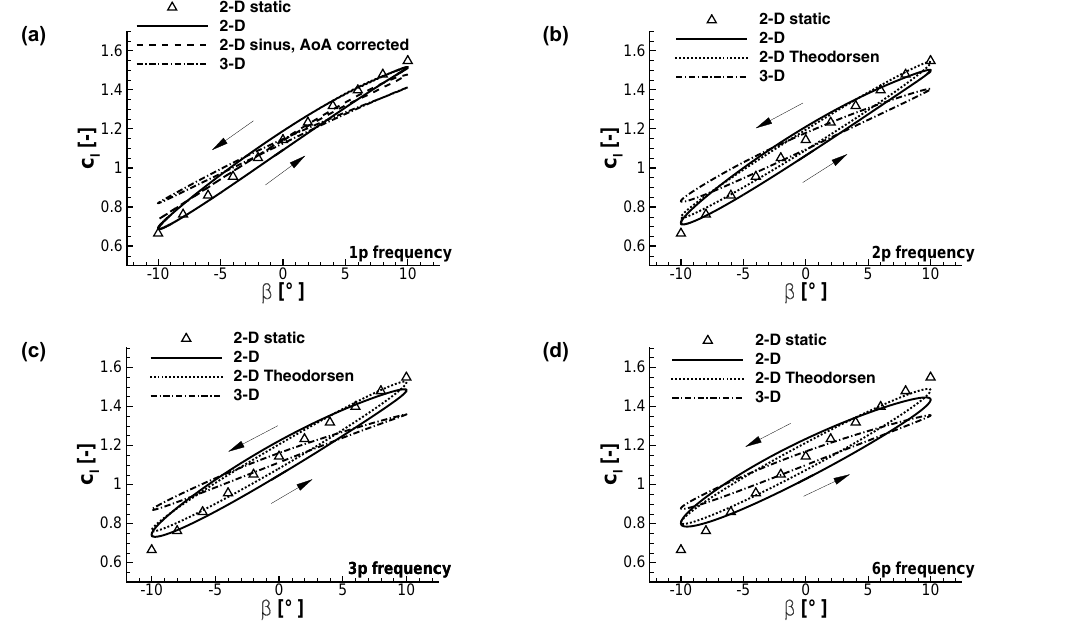
Figure 20. Comparison of 2-D/3-D lift for different flap frequencies: 1p (a) , 2p (b) , 3p (c) and 6p (d) .